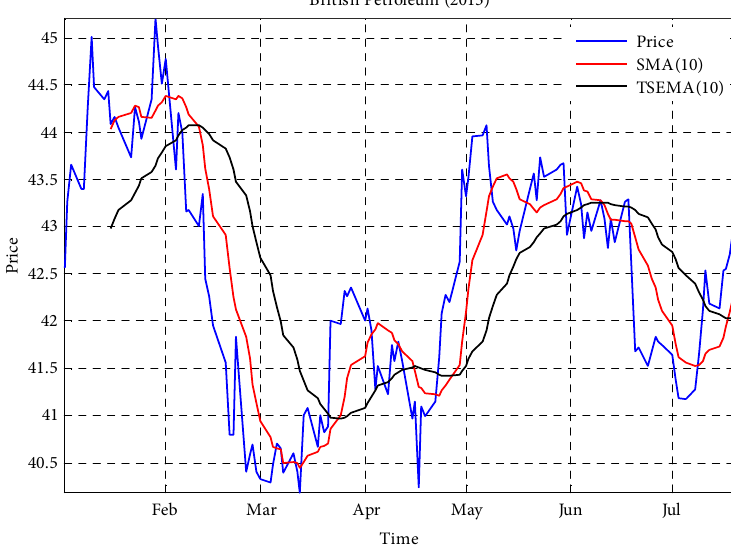
Fig. 1. The equal periods of 10 days for different MA generate different